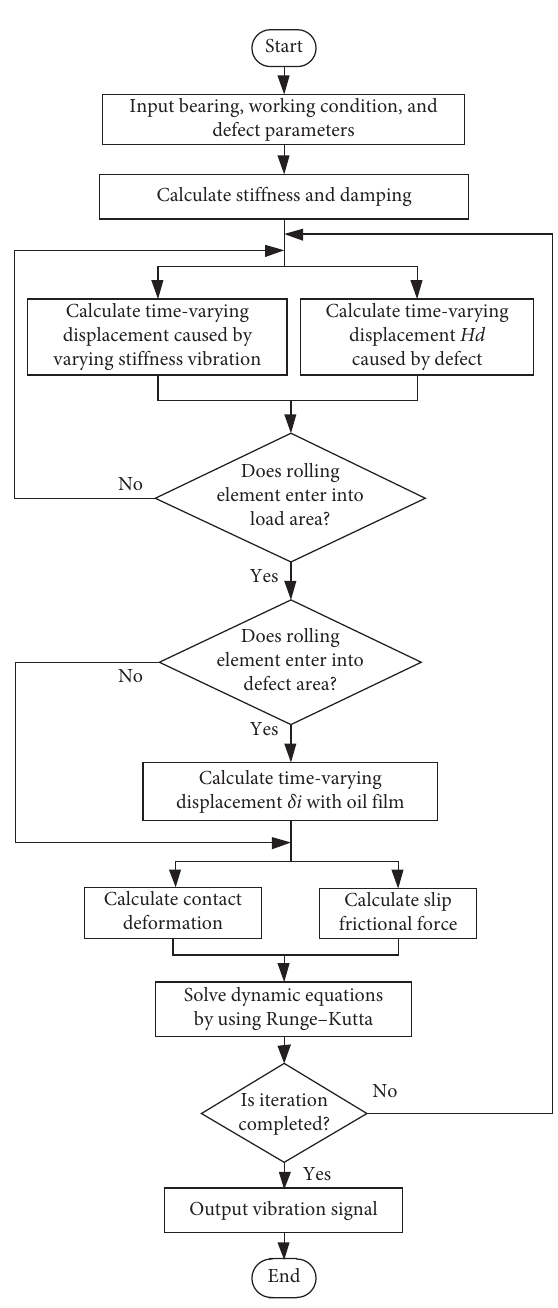
Figure 11: Flowchart for numerical computation.